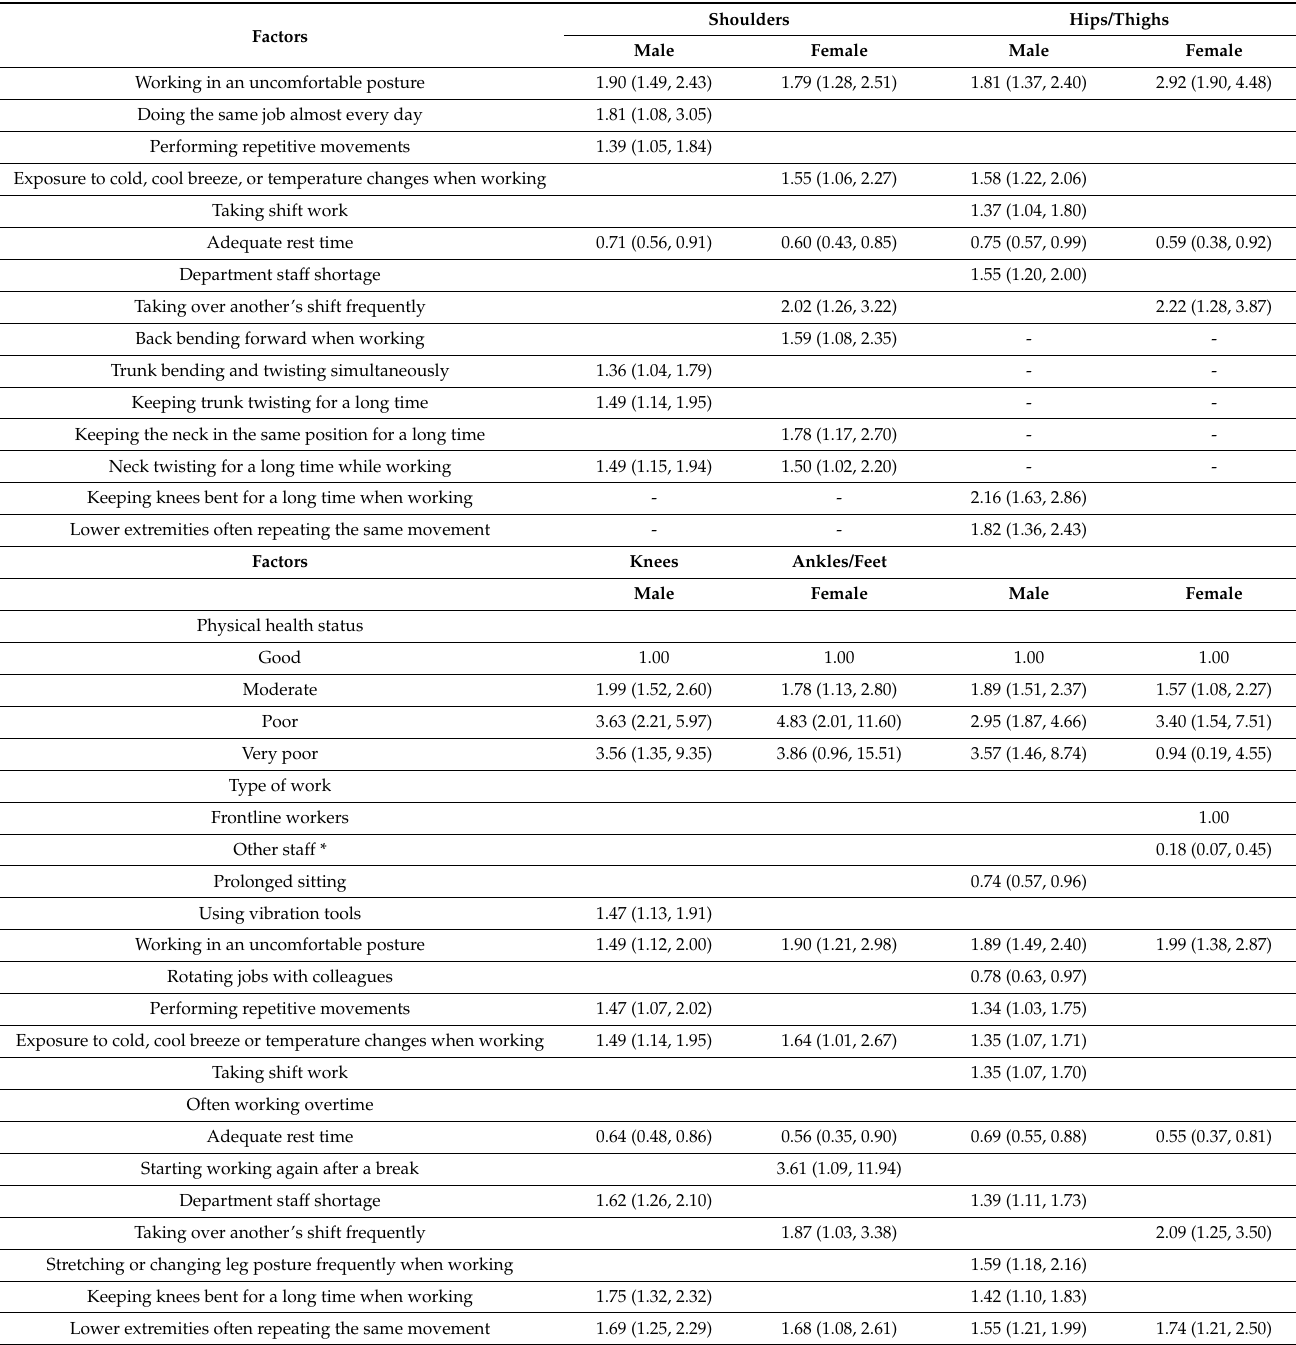
3.2.1. The Risk Factors for WMSD Symptoms in the Sites of the Neck and Trunk The results of the multivariate analysis for WMSD symptoms in the neck, the upper back, and the lower back are shown in Table 3. The following factors were related to the development of WMSDs in the neck, the upper back, and the lower back, with OR s ranging from 1.32 to 3.63: workers in moderate/poor/very poor physical health , working in an uncomfortable posture , exposure to cold, cool breeze or temperature changes when working , taking over another’s shift frequently , back bending forward when working Two factors— keeping the back in the